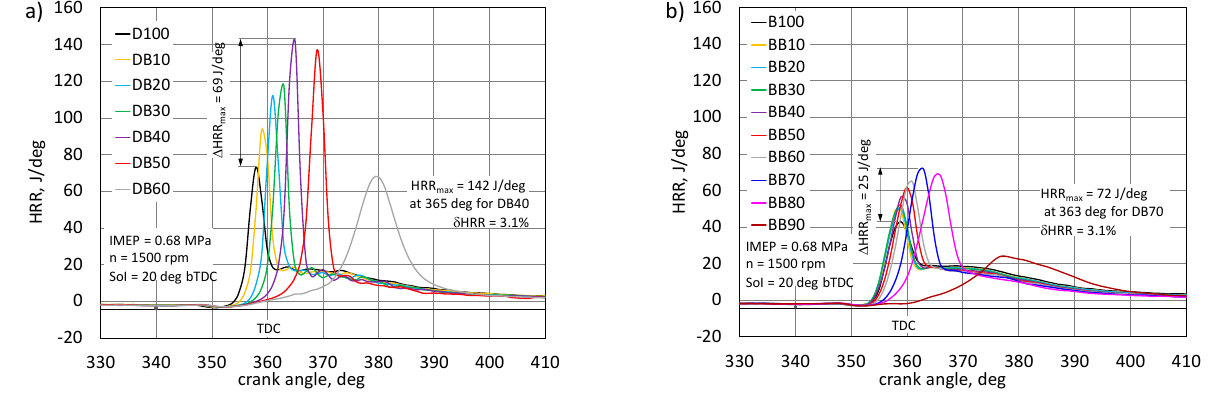
Figure 6. Comparison of the heat release rate for an engine powered by a mixture of diesel fuel with n ‐ butanol (DB) ( a ) and RME biodiesel with n ‐ butanol (BB) ( b ).